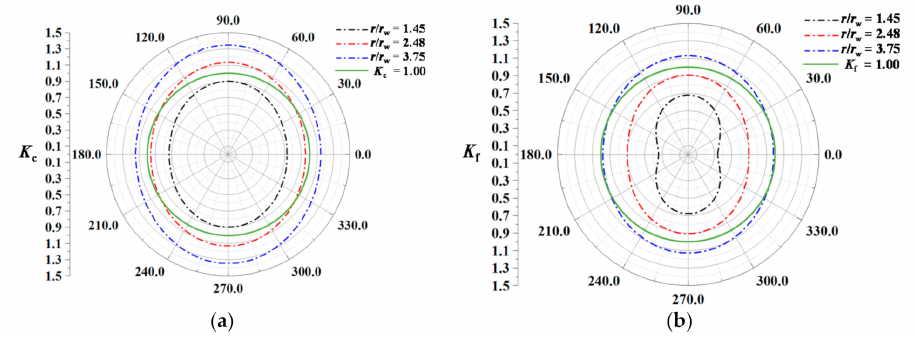
Figure 11. Comparison of the collapse coefficients and rupture coefficients of the A 1 B 1 section at different depths:( a ) collapse coefficients; ( b ) rupture